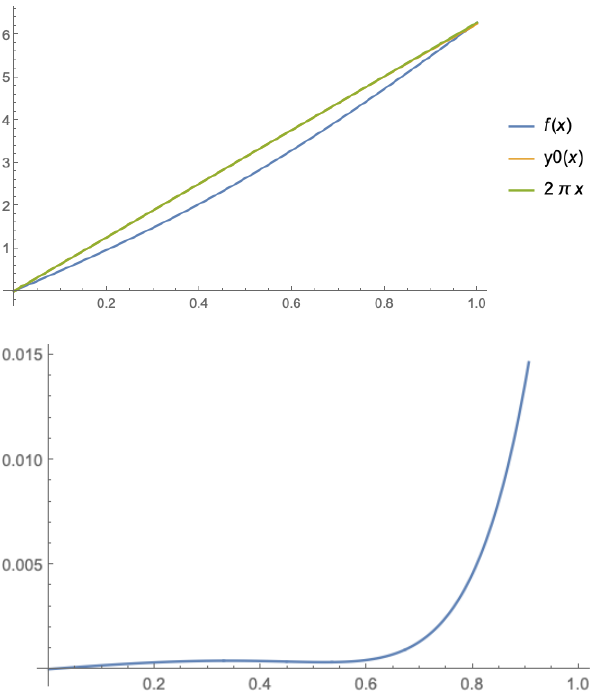
Figure 1. On the left, the graphics of the first approximation to the solution of the integral Equation (21) and the exact solution y ∗ ( x ) = 2 π x . On the right, the graphics of the corresponding